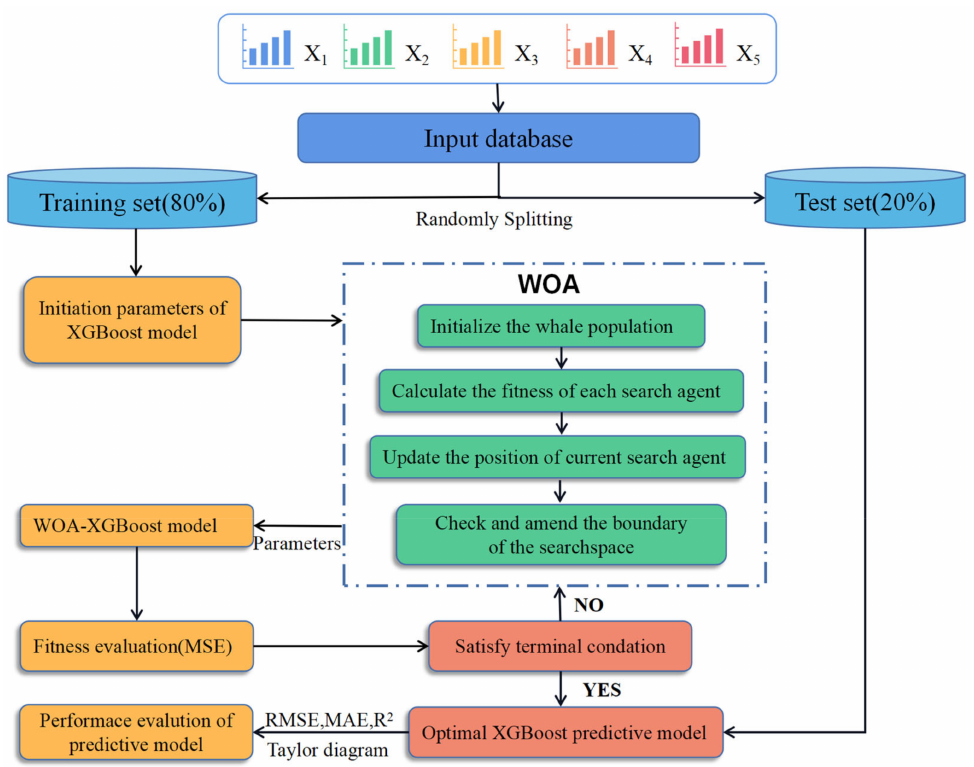
Figure 2. The analysis process of the WOA-XGBoost